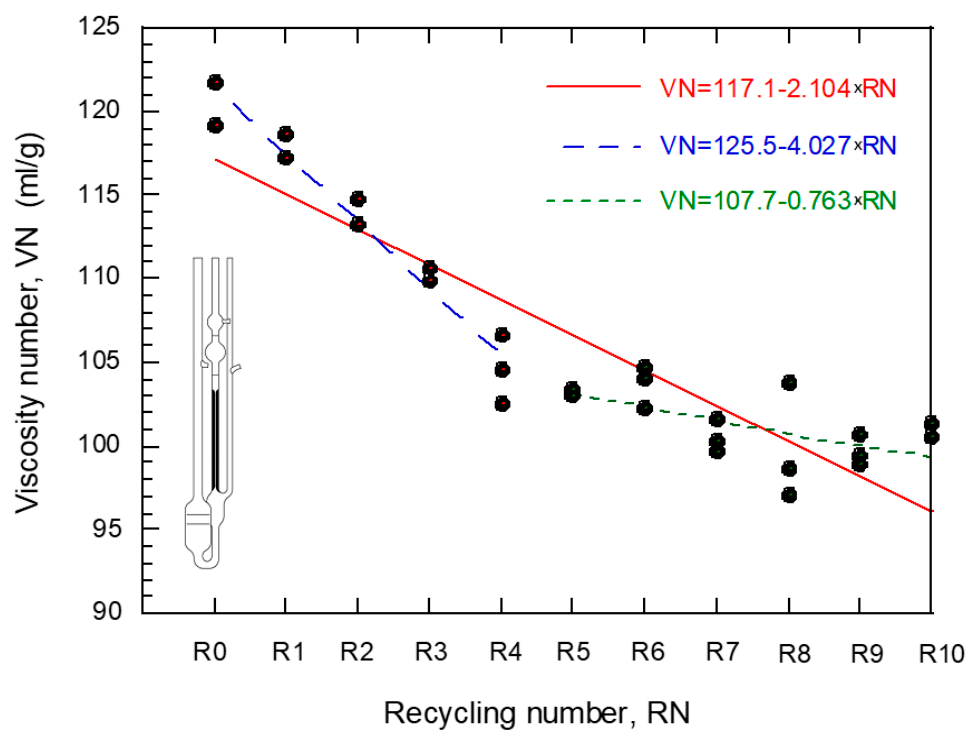
Figure 3. Evolution of the viscosity number, VN, with the number of recyclings, RN, applied. Table 4. Summary of results obtained from the linear fitting (VN = β 0 + β 1 · RN) of the viscosity (VN is expressed in mg/L). The coefficients β 0 and β 1 are accompanied with their 95% confidence